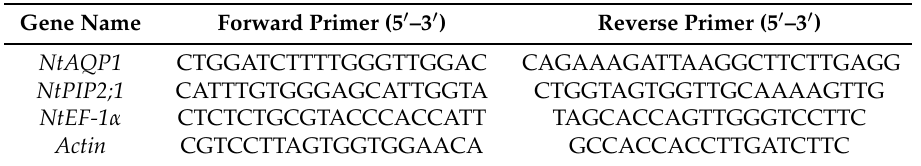
Table 1. List of primers used for quantitative Real Time